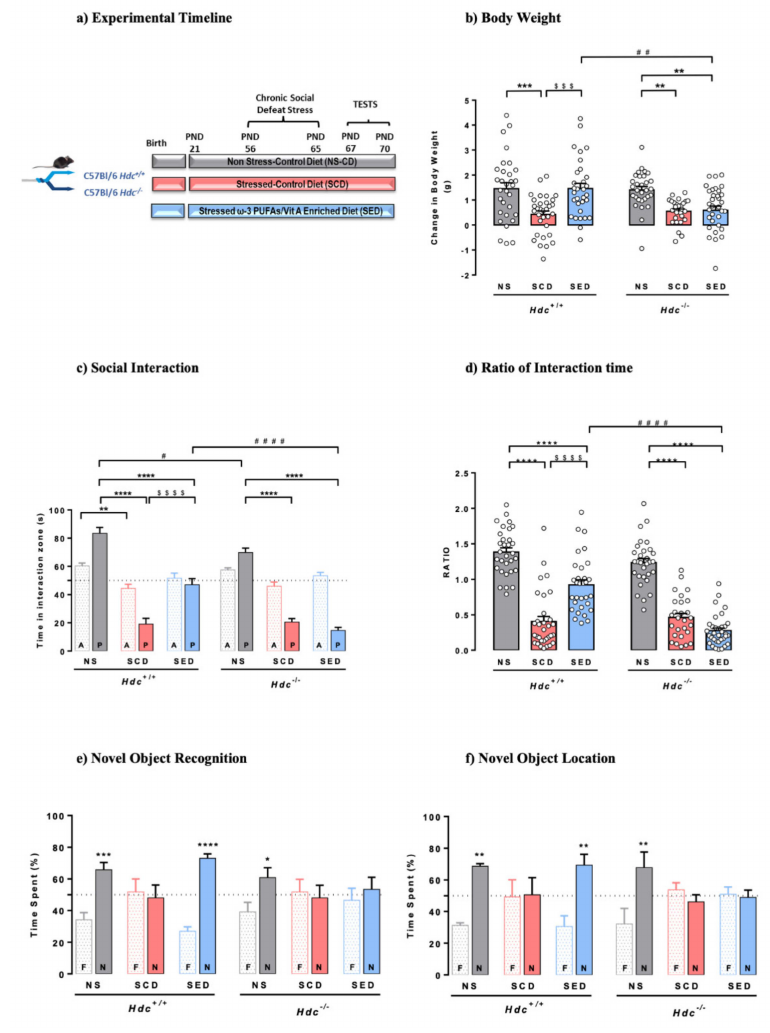
Figure 1. ( a ) Timeline for the chronic social defeat stress protocol and diet supplementation. Mice were randomly assigned to three experimental groups per genotype. ( b ) Effects of stress and n-3 LC-PUFA+VitA enriched diet on weight gain. Data are expressed as means ± S.E.M. of 27–34 mice per experimental group. *** p < 0.001; ** p < 0.01 vs. respective NS mice; $$$ p < 0.001 vs. SCD mice; ## p < 0.01 vs. same treatment of different genotype. NS = non-stressed; SCD = stressed, control diet; SED = stressed, enriched diet; ( c , d ) Effect of stress and the enriched diet on social-avoidance behaviour induced by stress expressed as time in the interaction zone ( c ) and social interaction ratio ( d ). P, target present; A, target absent. Data are represented as means ± S.E.M. of 27–34 mice per experimental group. **** p < 0.0001; ** p < 0.01 vs. respective NS mice; $$$$ p < 0.0001 vs. respective SCD mice; #### p < 0.001, # p < 0.05 vs same treatment of different genotype. ( e , f ) Effect of the enriched diet on stress-induced cognitive impairment in the novel object recognition test ( e ) and novel location recognition ( f ) Data are represented as means ± S.E.M. of 5–9 mice per experimental group in the NOR and mean ± S.E.M. of 5-6 mice per experimental group in the NOL. N, novel object; F,